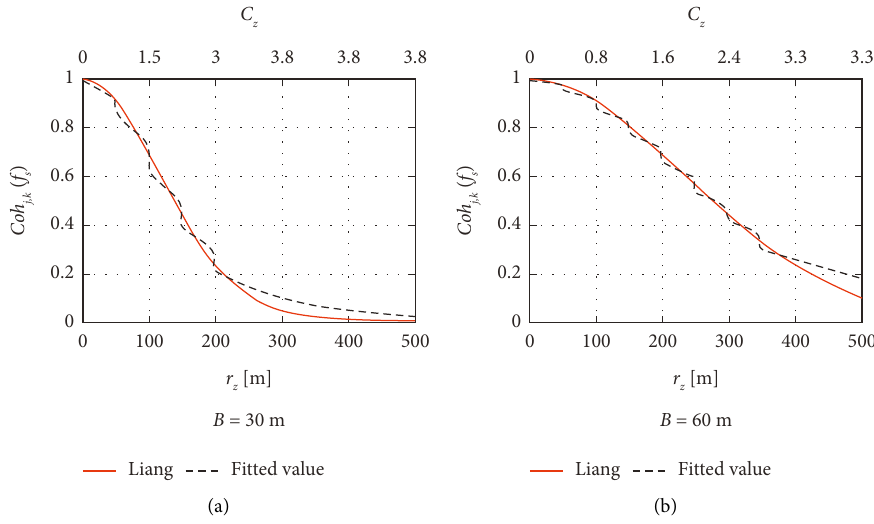
Figure 11: Vertical correlation at vortex shedding frequency for wind-induced torque: D/B �